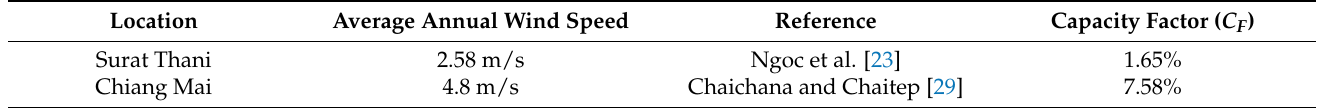
Table 2. Average annual wind speed and capacity factors for Surat Thani and Chiang Mai. Location